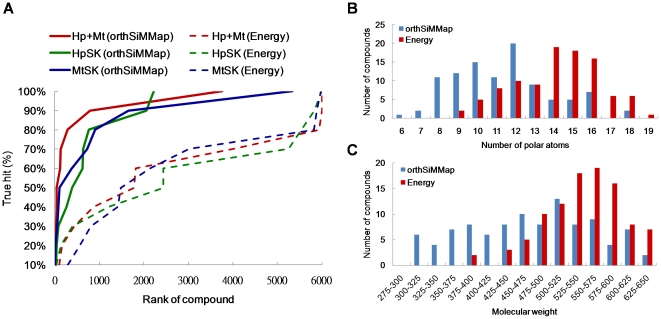
Performance of CoreSiMMap method on apo-form HpSK and MtSK.(A) True-hit rates of energy-based and CoreSiMMap scoring approaches. The CoreSiMMap scores (solid line) of adaptive inhibitors are significantly better than the energy-based scores (dashed line) for the 6000 top-ranked compounds by combining the Maybridge and NCI databases. (B) Distribution of number of polar atoms. (C) Molecular weights of top 100 compounds from CoreSiMMap scores and energy-based scores.